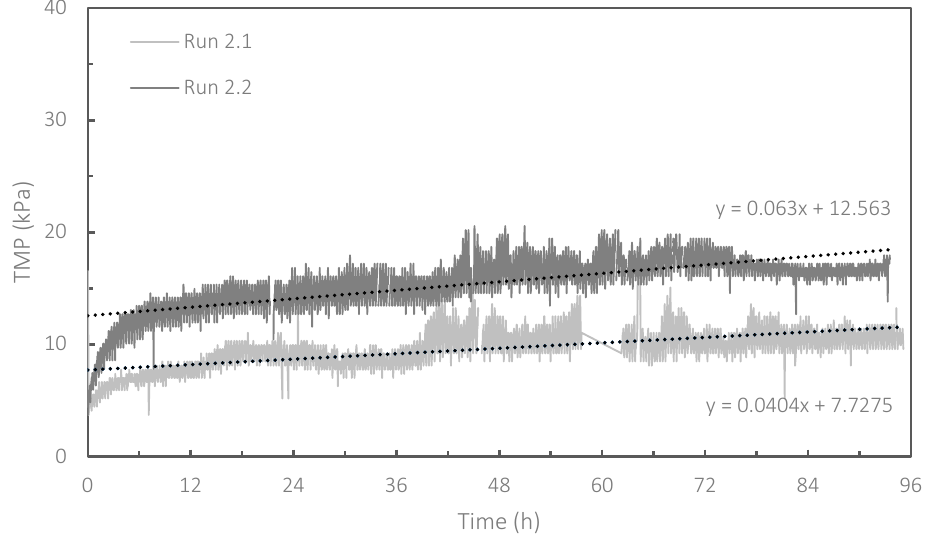
Figure 5. Increases in TMP in Runs 2.1 and 2.2. The dotted lines represent the linear regression of TMP evolutions. During Run 2.1, at around 2.5 days of operation, a power outage that lasted 4 h stopped all activity in the experimental system.